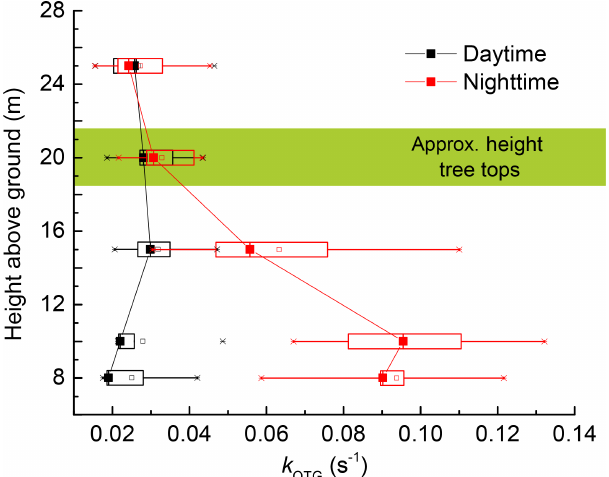
Figure 11. Vertical profiles of NO 3 reactivity ( k OTG ) on 17–18 September 2016. The data represent the average of five profiles dur- ing the day and nine profiles during the